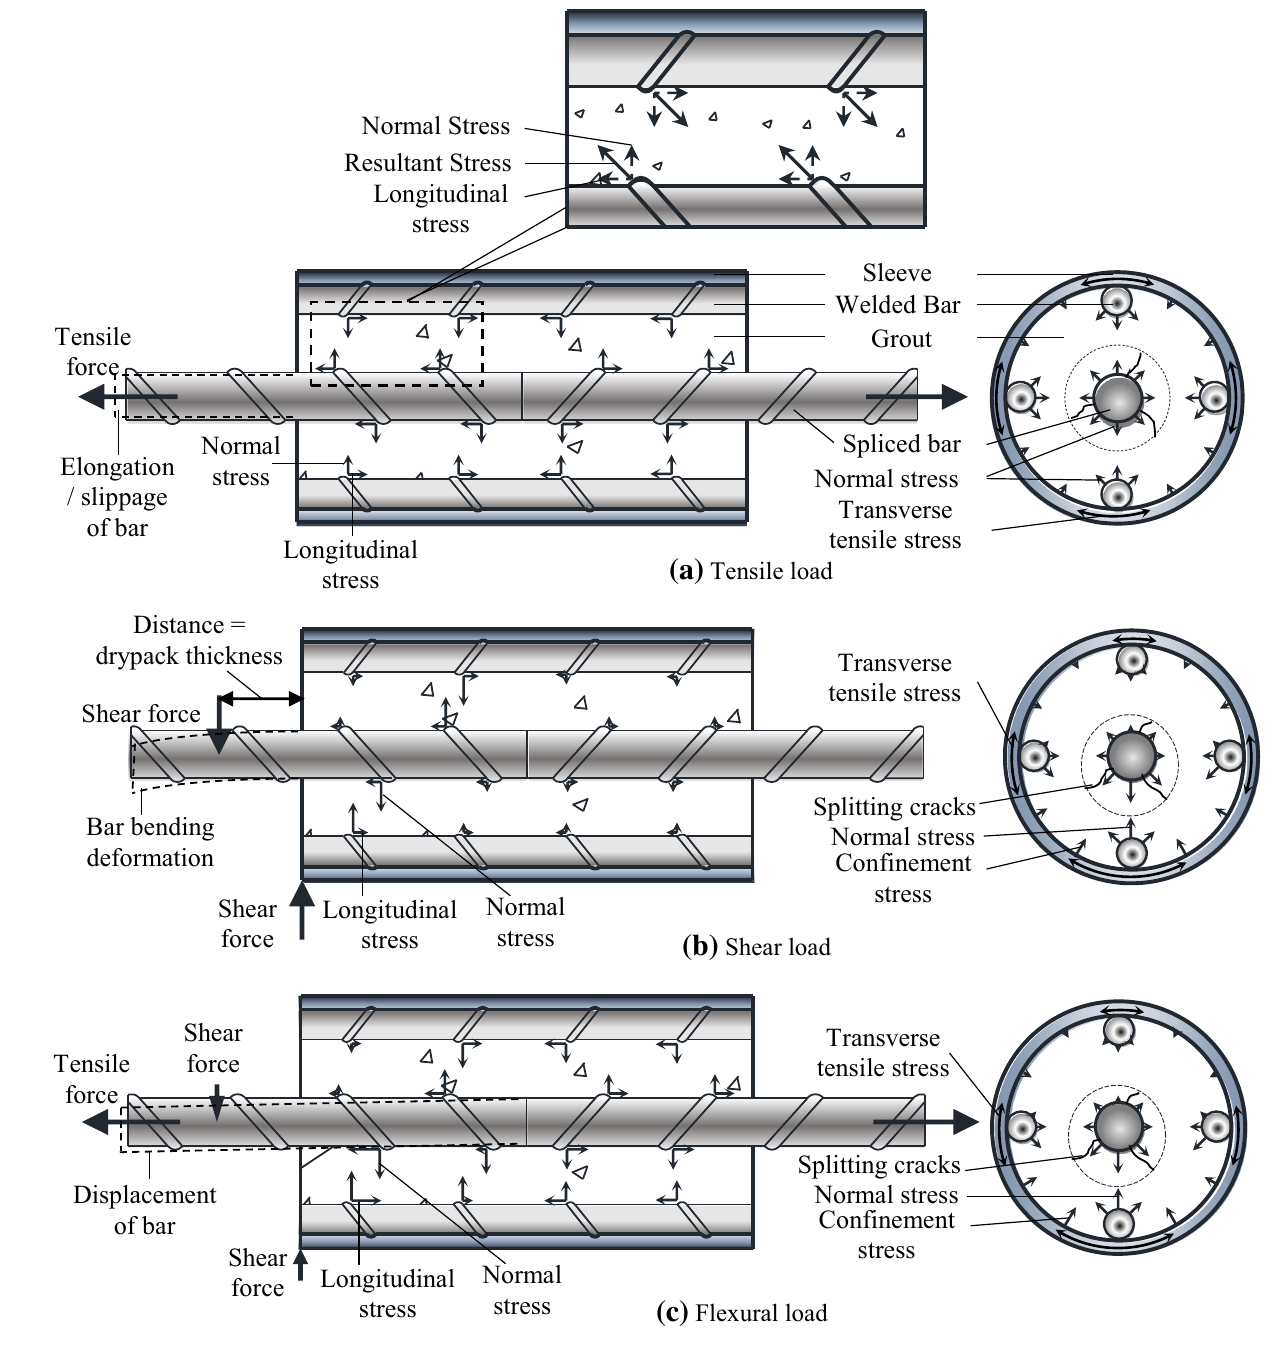
Fig. 14 The internal stress in WBS varies slightly under different load